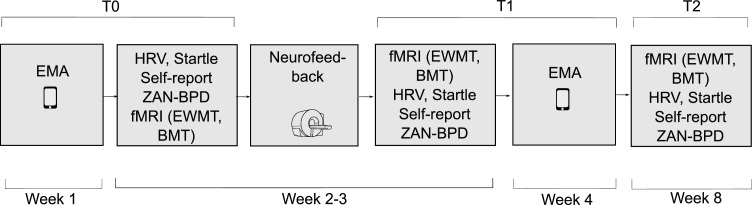
Participants received a total of 4 runs of amygdala neurofeedback training (weeks 2–3). Runs were administered on 3 different days, with run 2 and 3 being administered consecutively on the second training day. At baseline (T0), participants completed an emotion test battery: ecological momentary assessment (EMA) was assessed on 4 consecutive weekdays before neurofeedback started (week 1). At the beginning of week 2, the Zanarini Rating Interview (ZAN-BPD), self-report questionnaires, heart rate variability (HRV), and an emotion regulation task with emotion-modulated startle (Startle) was administered. Participants also answered an Emotional Working Memory Task (EWMT) and a Backward Masking Task (BMT) during fMRI, immediately before completion of the first neurofeedback session. From 2 to 7 days later, participants completed the next neurofeedback session (visit 2), followed by 2–7 days for their third and final session (visit 3). During these sessions, participants were instructed to downregulate a thermometer, with activity of the right amygdala, while watching aversive pictures. Details of the neurofeedback procedure can be found in the supplement. Immediately after the last neurofeedback session (end of week 3), the test battery was administered a second time (T1). The follow-up visit (T2) was completed 6 weeks after visit 3, and was identical to T1, excluding EMA (week 8).